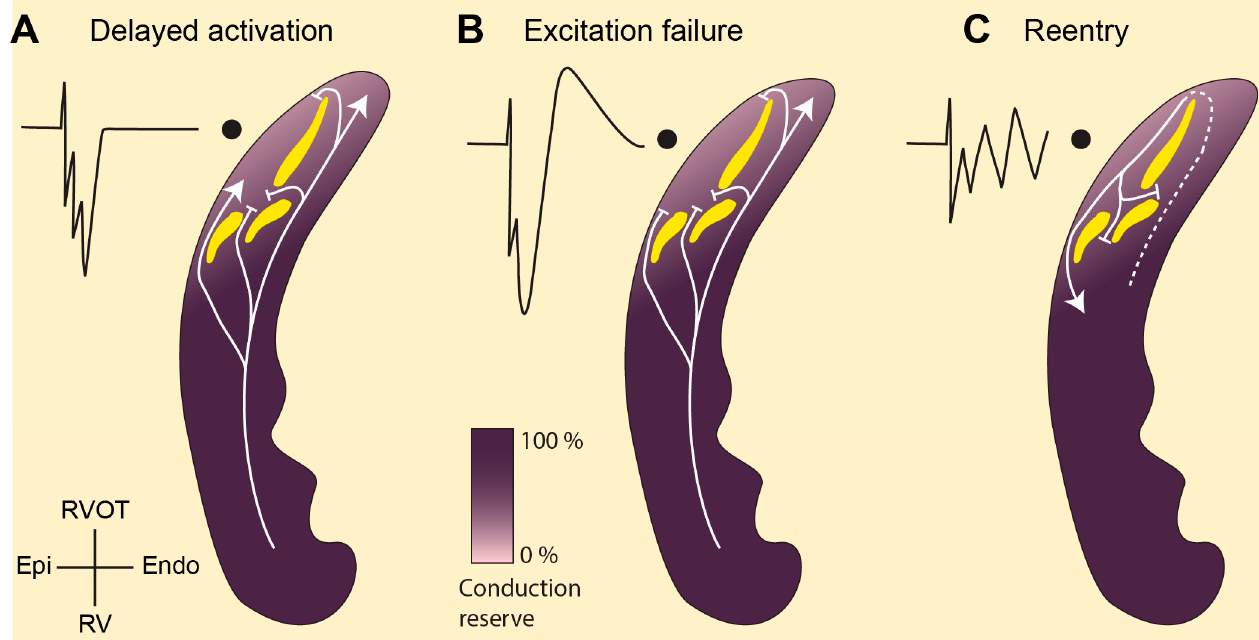
Figure 1. Abnormal conduction in the right ventricular outflow tract (RVOT) as explanation for the Brugada syndrome. ( A ). The structural abnormalities (yellow) in the RVOT separate activation fronts causing fractionated unipolar electrograms. ( B ). The abnormalities may also set the stage for current ‐ to ‐ load mismatch leaving part of the myocardium unexcited. This myocardium acts as a current sink during systole and receives current from adjacent—excited—tissue causing unipolar electrograms with ST segment elevation (J ‐ point). ( C ) Current ‐ to ‐ load mismatch may also generate unidirectional block and the onset of reentry. The lighter shade of purple in the RVOT indicates a lower conduction reserve resulting from a distinct embryonic origin [28]. RVOT, right ventricular outflow tract; RV, right ventricle; Endo, endocardium; Epi, epicardium.